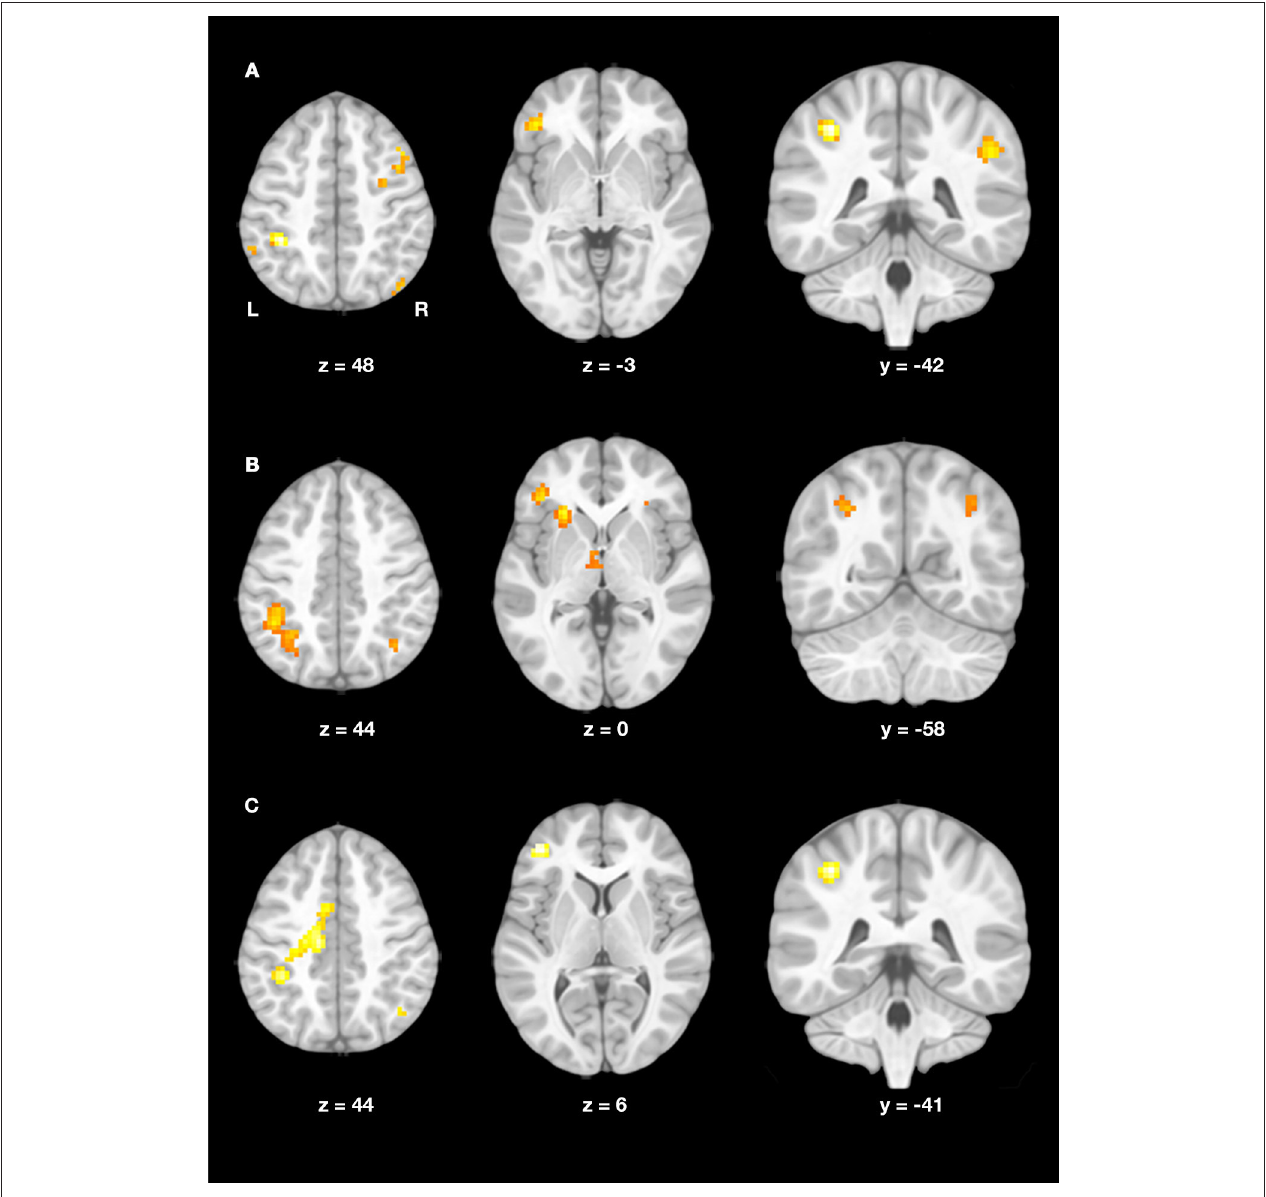
FIGURE 4 | (A) Group differences at follow-up. Increased activation in the dyscalculic compared to the typically developing group at the follow-up assessment ( post-hoc t -test for the contrast DD vs. TD, p < 0.001, k ≥ 19, cluster-extent corrected). (B) Developmental increase in DD. Increase in brain activation in the dyscalculic group over developmental time ( post-hoc t -test for the contrast follow-up vs. baseline, p < 0.005, k ≥ 22, cluster-extent corrected). (C) Negative interaction. Activation increase over time was more pronounced in children with dyscalculia compared to typically developing children (group by time interaction, p < 0.005, k ≥ 22, cluster-extent